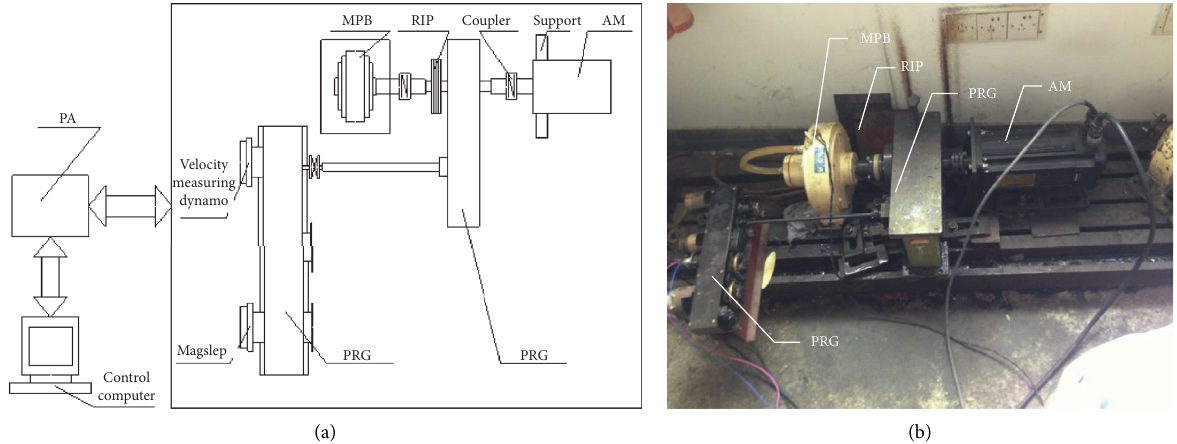
Figure 8: Semiphysical workbench